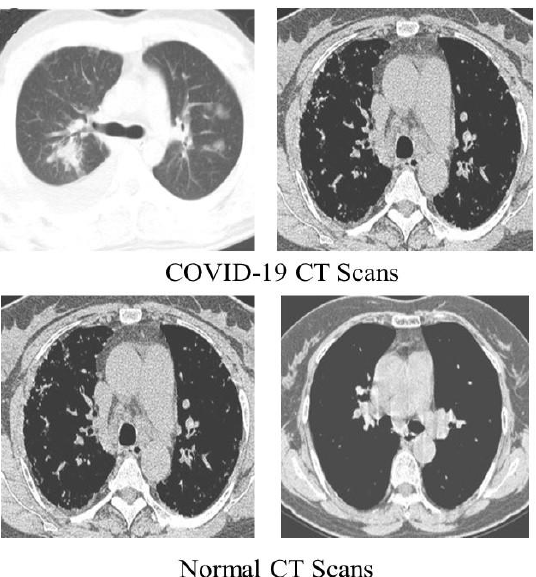
Figure 4. COVID-19 (first row) Normal CT scan (second row) samples of the dataset.